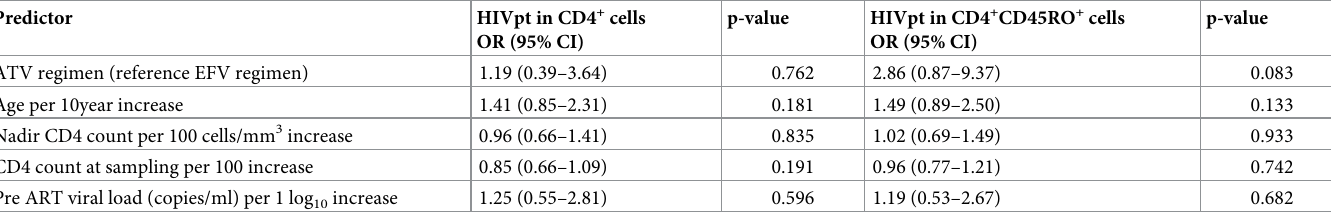
Table 2. Predictors of HIV persistent transcription(HIVpt) in univariate logistic regression models.